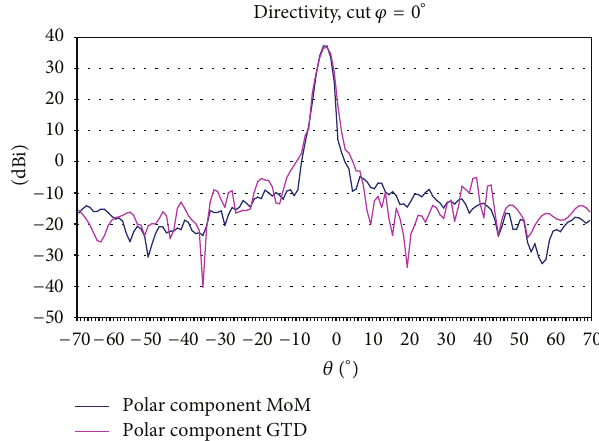
Figure 22: Polar component obtained with MoM and GTD, cut in phi = 45.